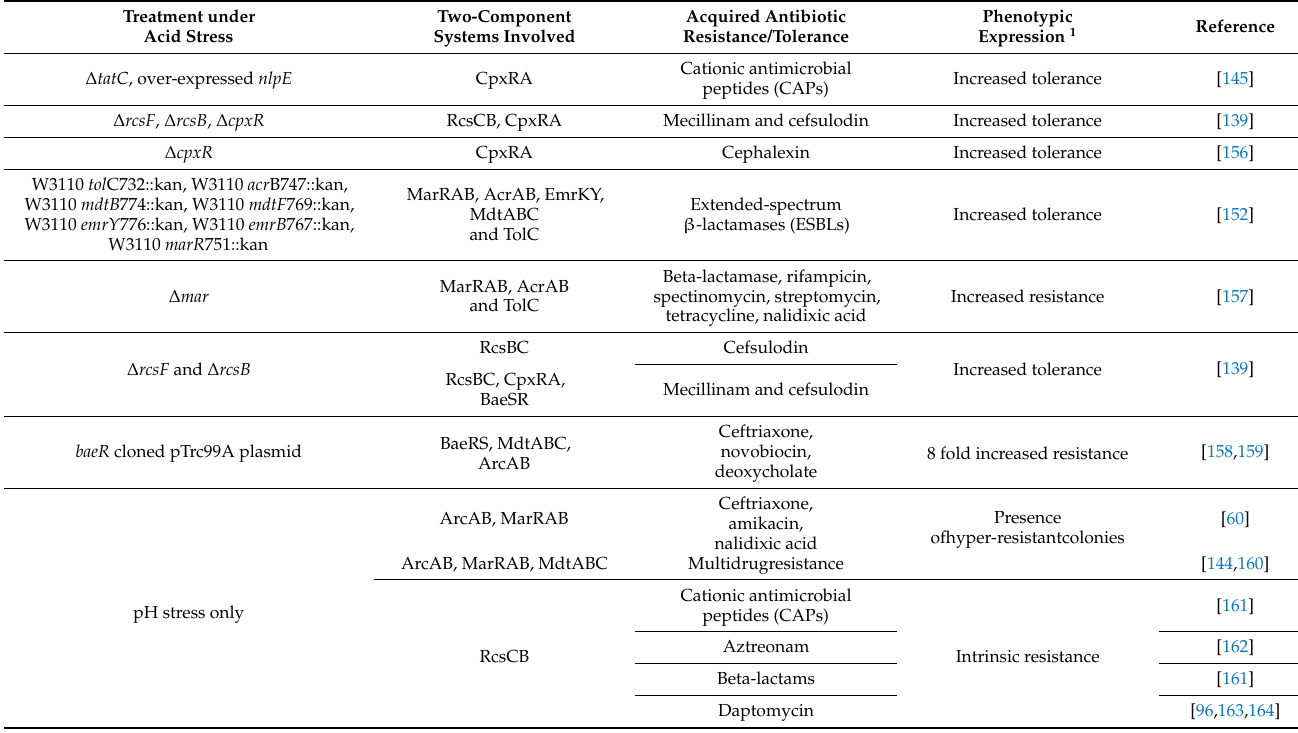
Table 3. Role of different two-component systems involved in mediating antibiotic resistance in response to acid stress. All abbreviations are listed at the end of the